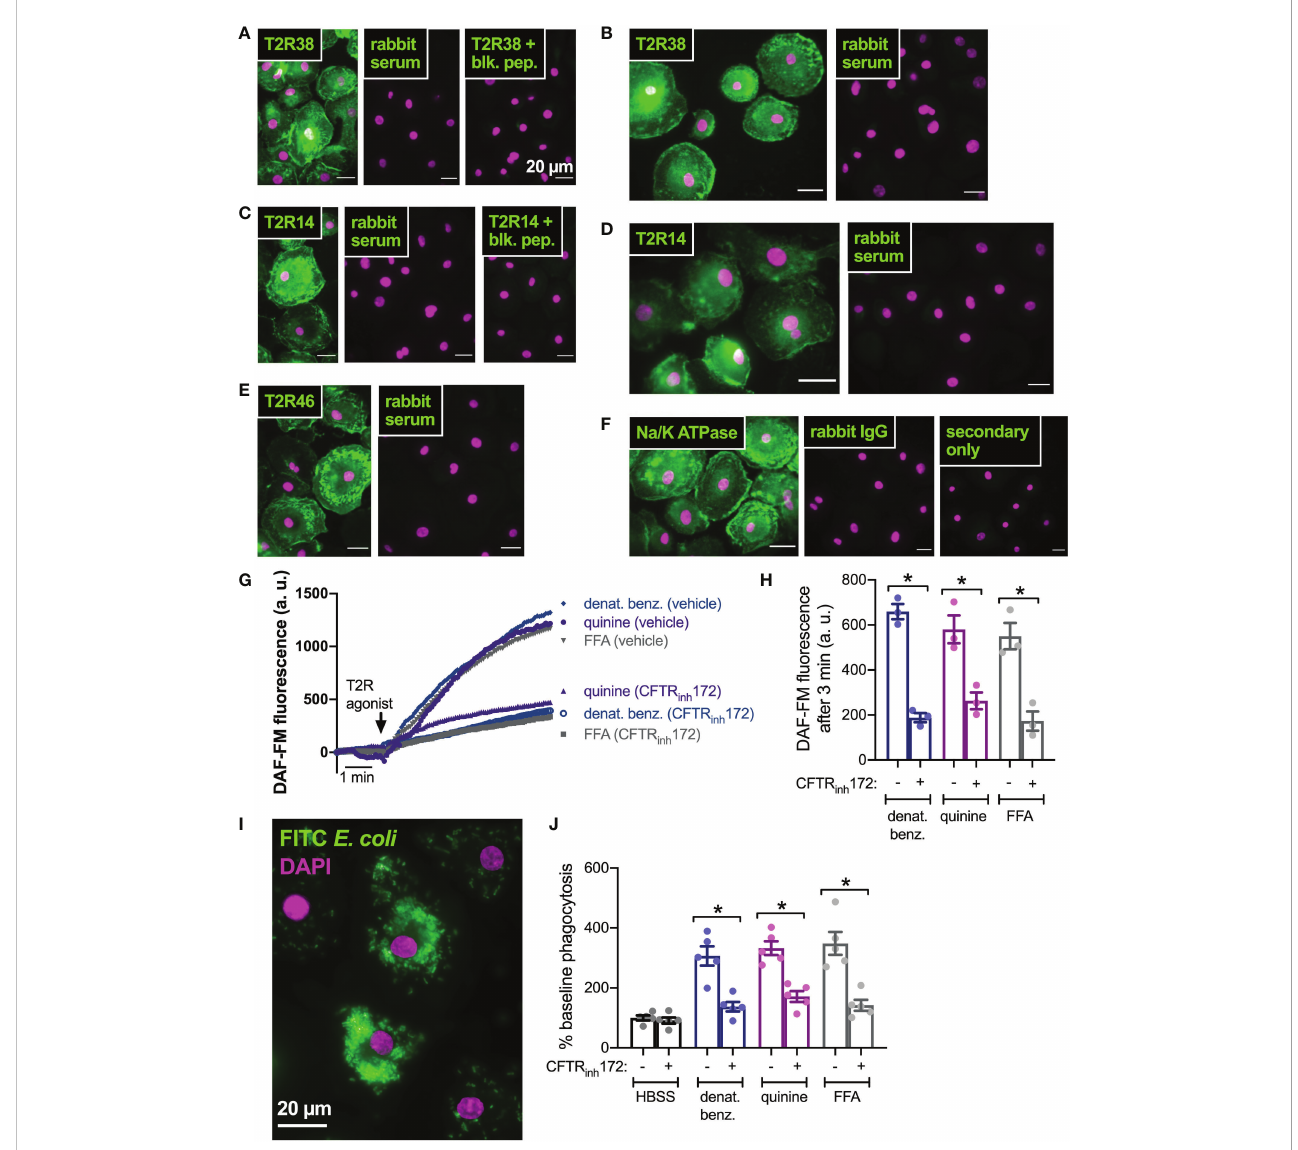
FIGURE 6 CFTR inhibition results in reduced T2R-stimulated NO production and NO/cGMP phagocytosis in human macrophages. (A) Macrophages exhibited staining reminiscent of plasma membrane ruf fl es with C-terminal T2R38 antibody (left panel) that was blocked in the presence of T2R38 blocking peptide (right panel). (B) A different T2R38 antibody resulted in similar staining. (C) Macrophages exhibited staining reminiscent of plasma membrane ruf fl es with C-terminal T2R14 antibody (left panel) that was blocked in the presence of T2R14 blocking peptide (right panel). (D-F) A different T2R14 antibody (D) and T2R46 antibody (E) also resulted in similar staining reminiscent of Na + /K + ATPase plasma membrane staining (F) . All data in A-F are representative of images taken from macrophages from >3 different donors stained in 3 different experiments. Af fi nity puri fi ed rabbit serum was used as a negative control for non-speci fi c staining of all polyclonal antibodies. (G, H) NO production was measured using DAF-FM. Cells stimulated with denatonium benzoate, quinine, or fl ufenamic acid (FFA) exhibited reduced NO production after incubation with CFTR inh 172. Representative traces